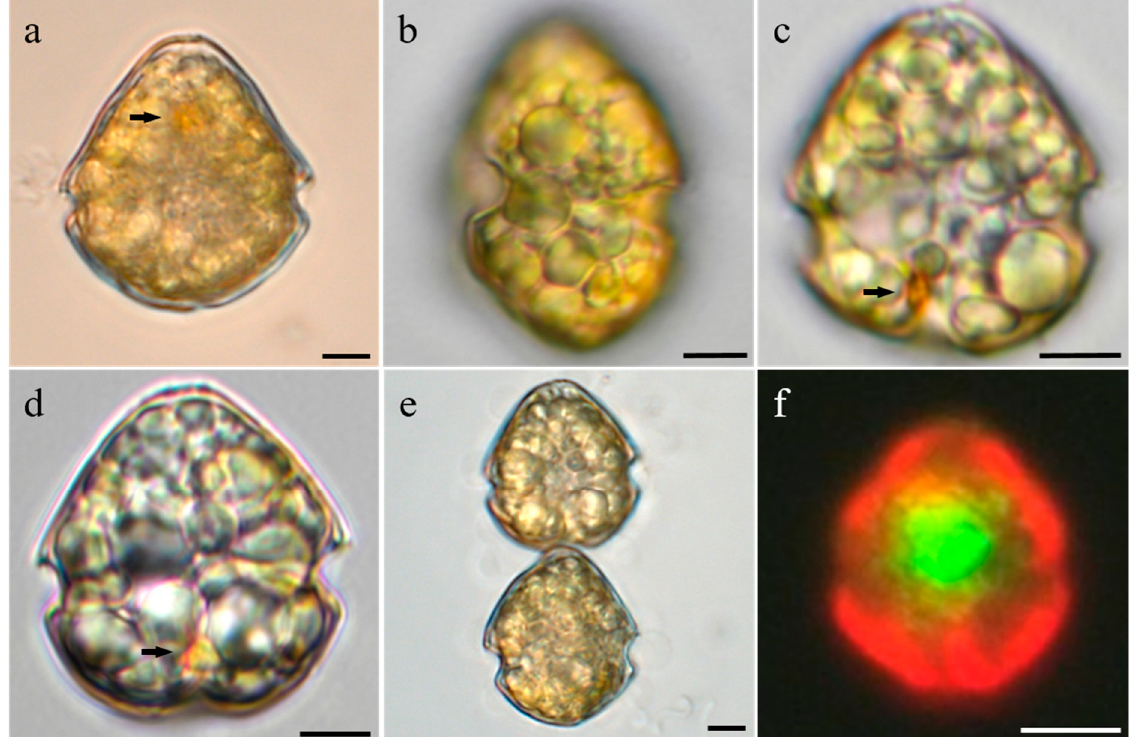
Figure 3. Light and fluorescence micrographs of Scrippsiella precaria (strains LMBE-C28 and LIMS-PS-2799): ( a ) ventral view showing a red pigment body in the epitheca, ( b ) left lateral view, ( c ) ventral view showing a red pigment body in the hypotheca, ( d ) dorsal view showing a red pigment body in the hypotheca, ( e ) two-celled chain, and ( f ) ventral view showing the position of the nucleus (green) and chloroplast (red). Scale bars: 5 µm.